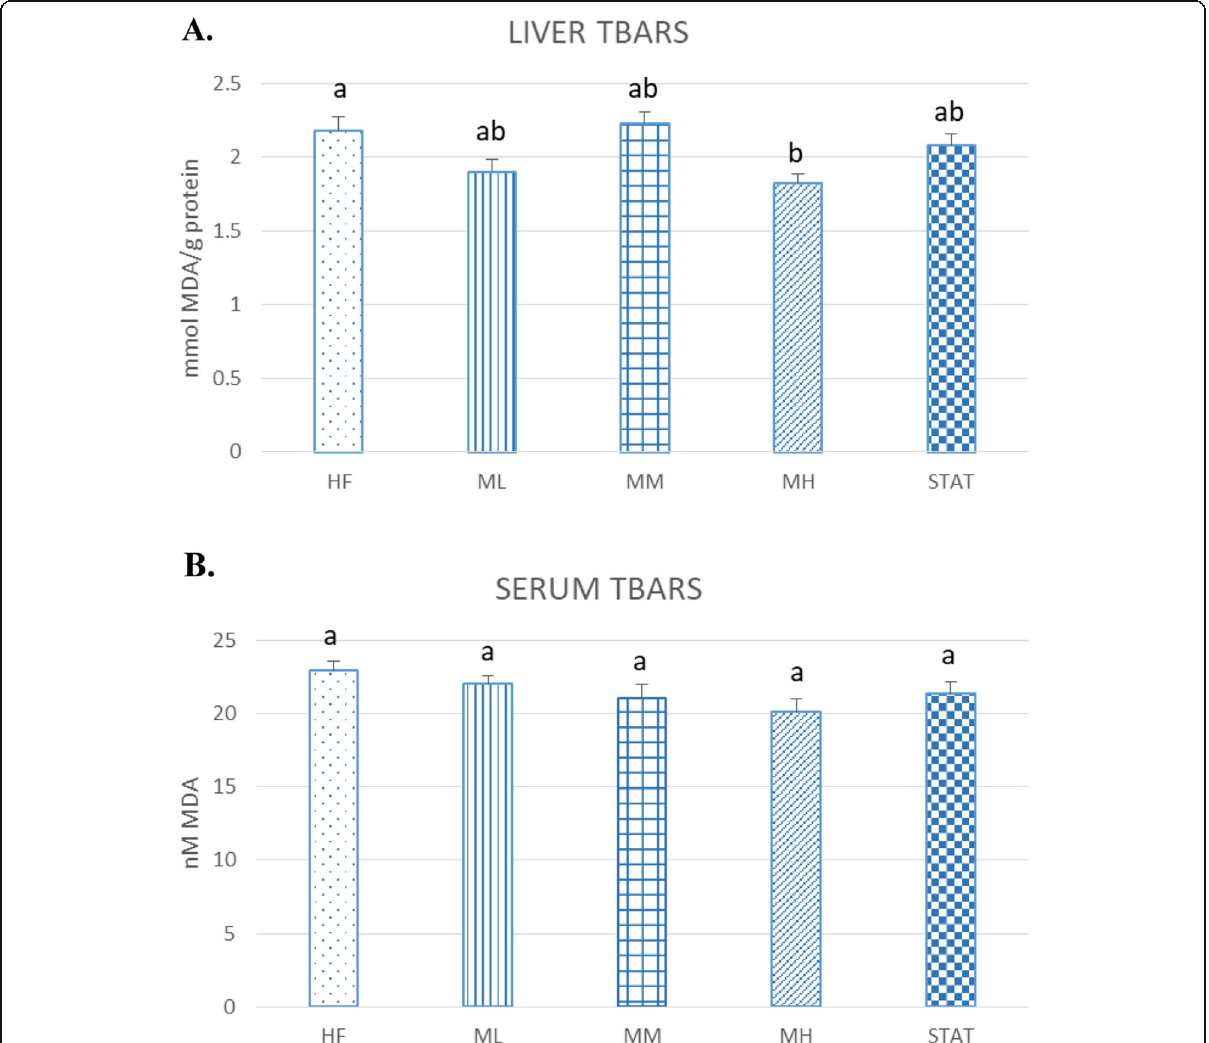
Fig. 1 Effect of Maoberry extract on ( a ) liver and ( b ) serum lipid peroxidation levels ( n = 12). The groups were classified as follows: high fat diet with no treatment (HF); three dosages of Mao-Luang extract (0.38 [ML], 0.76 [MM] or 1.52 [MH] g/kg BW) and 10 mg/kg of STAT. Values are expressed as means ± SEM. Different letters indicate significant difference among group at P <